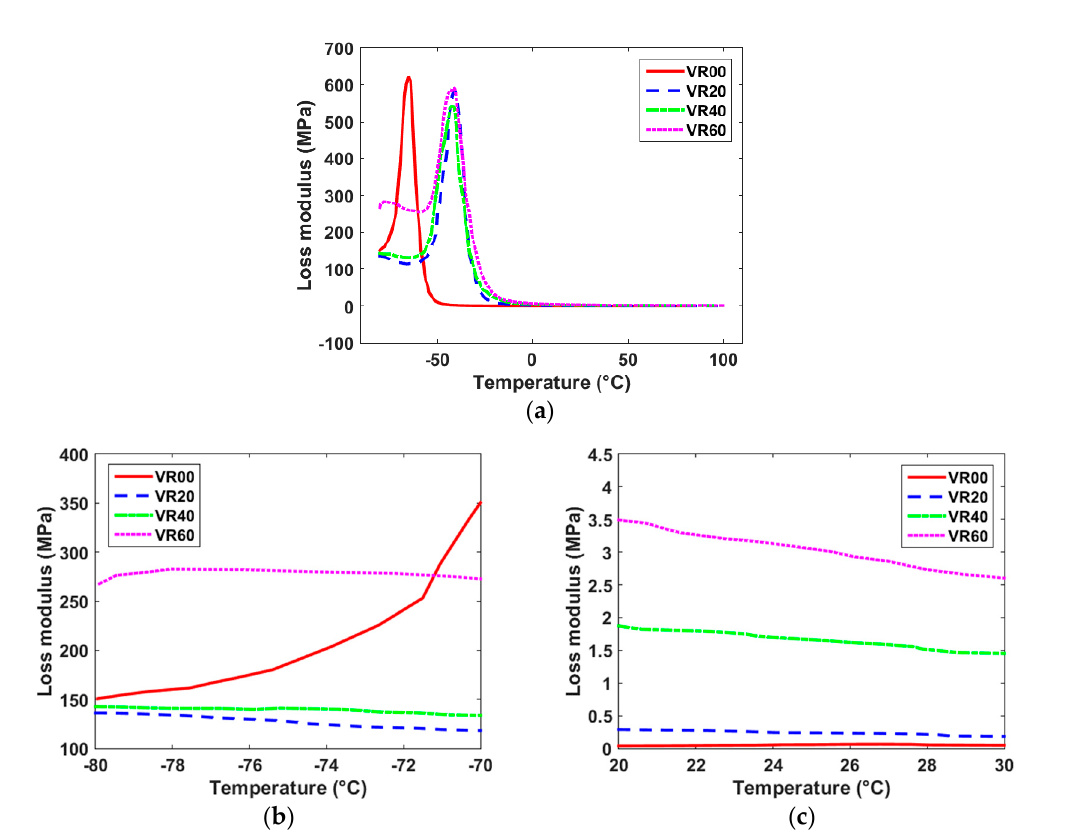
Figure 4. Loss modulus vs. temperature curves for the four vulcanizates ( a ) from − 80 °C to 100 °C, ( b ) loss modulus variation from − 80 °C to − 70 °C, ( c ) loss modulus variation from 20 °C to 30 °C.